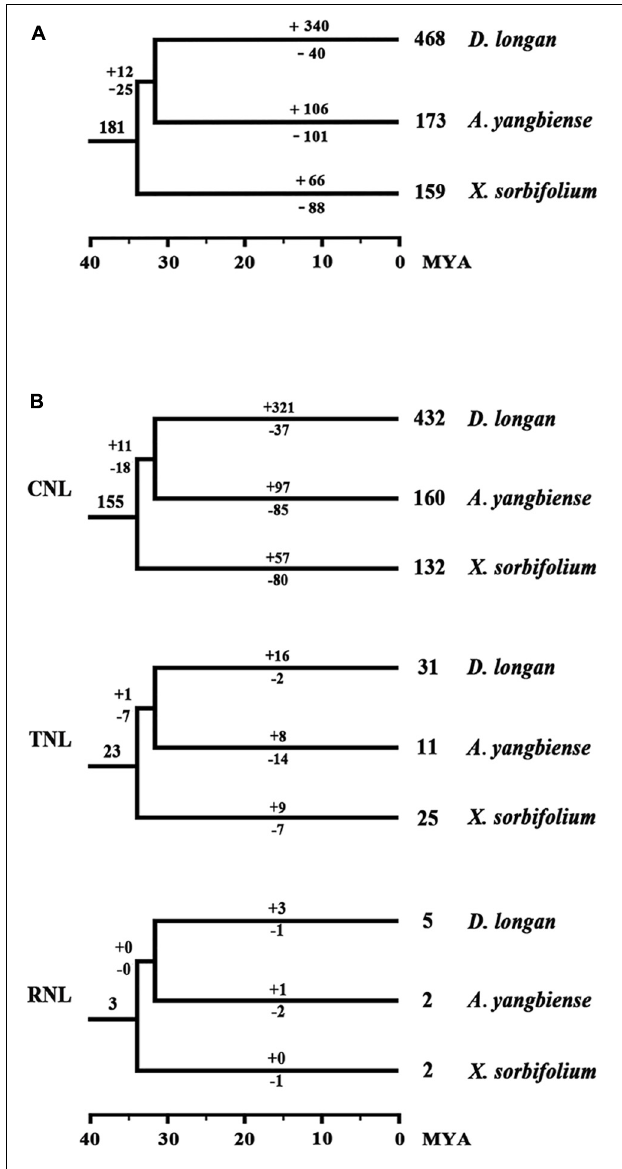
FIGURE 5 | Duplication/loss events of the NBS-encoding genes during the speciation of X. sorbifolium , A. yangbiense , and D. longan . (A) Differential gene duplication and loss events of NBS-encoding genes. (B) Duplication/loss events of CNL, TNL, and RNL genes. Gene duplication/loss events are indicated by numbers with “+” or “ − ” on each branch, respectively. Detailed information for the duplication/loss events of the NBS-encoding genes are presented in Supplementary Figure S6